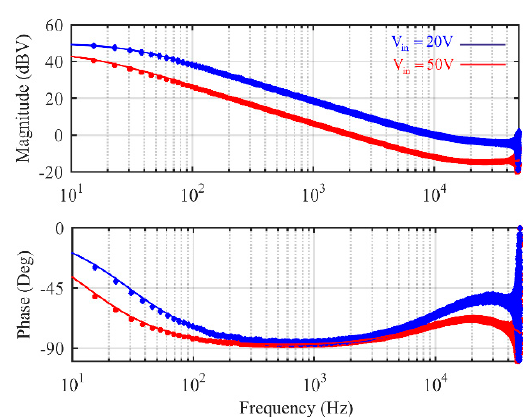
Figure 2. The frequency responses of the control-to-output-voltage transfer function of the direct-duty-ratio (DDR)-controlled boost converter at the input voltages of 20 V (red) and 50 V (blue). The solid lines denote the predicted responses, and the squares (20 V) and diamonds (50 V) denote the simulated